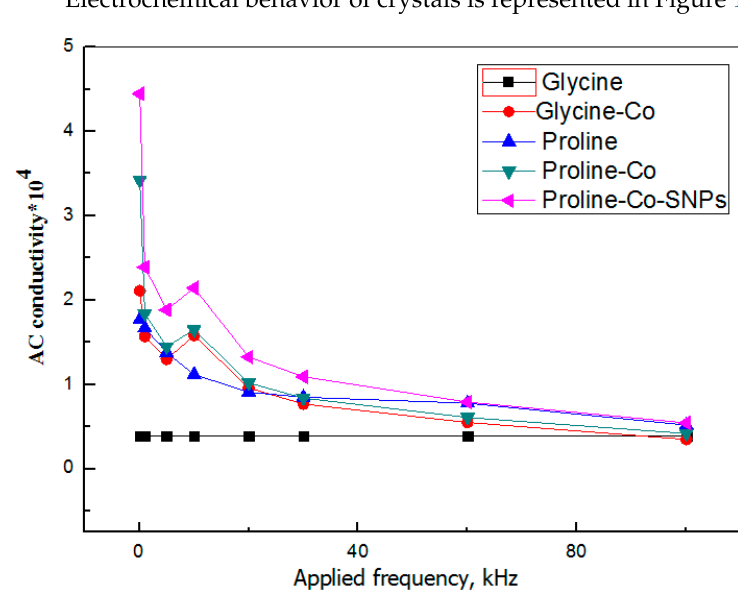
Figure 13. Variation of AC conductivity of crystals with applied frequency. The AC conductivity of the sample is decreased with increasing frequency less than 10 5 Hz due to charges entrapped between grain boundaries and grains. The AC conduc- tivity of crystals is enhanced by SNPs doping. High electric conductivity of samples ena- bled the applications as new thermoelectric materials for decreasing heat wastes for the 4th generation of solar cells, new high-temperature superconductors and mini-magnets [44]. Proline showed no antimicrobial activity to any tested species. SNPs enhanced anti- bacterial activity of Co(II)-proline single crystals based on inhibition zones (IZ, mm), Table 9. Table 9. Antimicrobial activities of the crystals expressed in inhibition zone. Sample